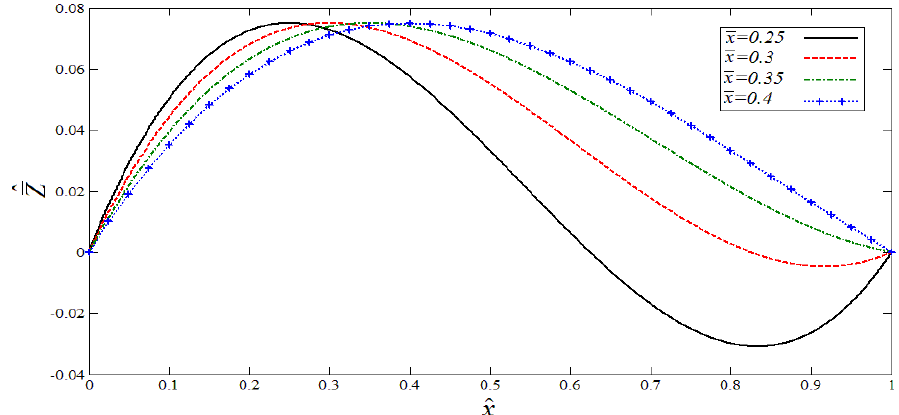
Linear the dashed line indicates the unstable solution which does not occur in the physical be- havior of the system [28]. The jump phenomena may occur in the system when the voltage frequency approaches the natural frequency from the right side by decreasing the detun- ing parameter and, accordingly, a sudden shift occurs in the amplitude of vibration to the upper curve, following the arrows [28]. Figure 4b is known as the response curve and depicts the influence of varying amplitude of parametric excitation on the vibration am- plitude, which can be assessed by changing the amplitude of the applied harmonic volt- age. The dashed line denotes the unstable solution and again, the jump phenomenon is observed by the red arrows depending on increasing or decreasing the excitation ampli- tude [28].